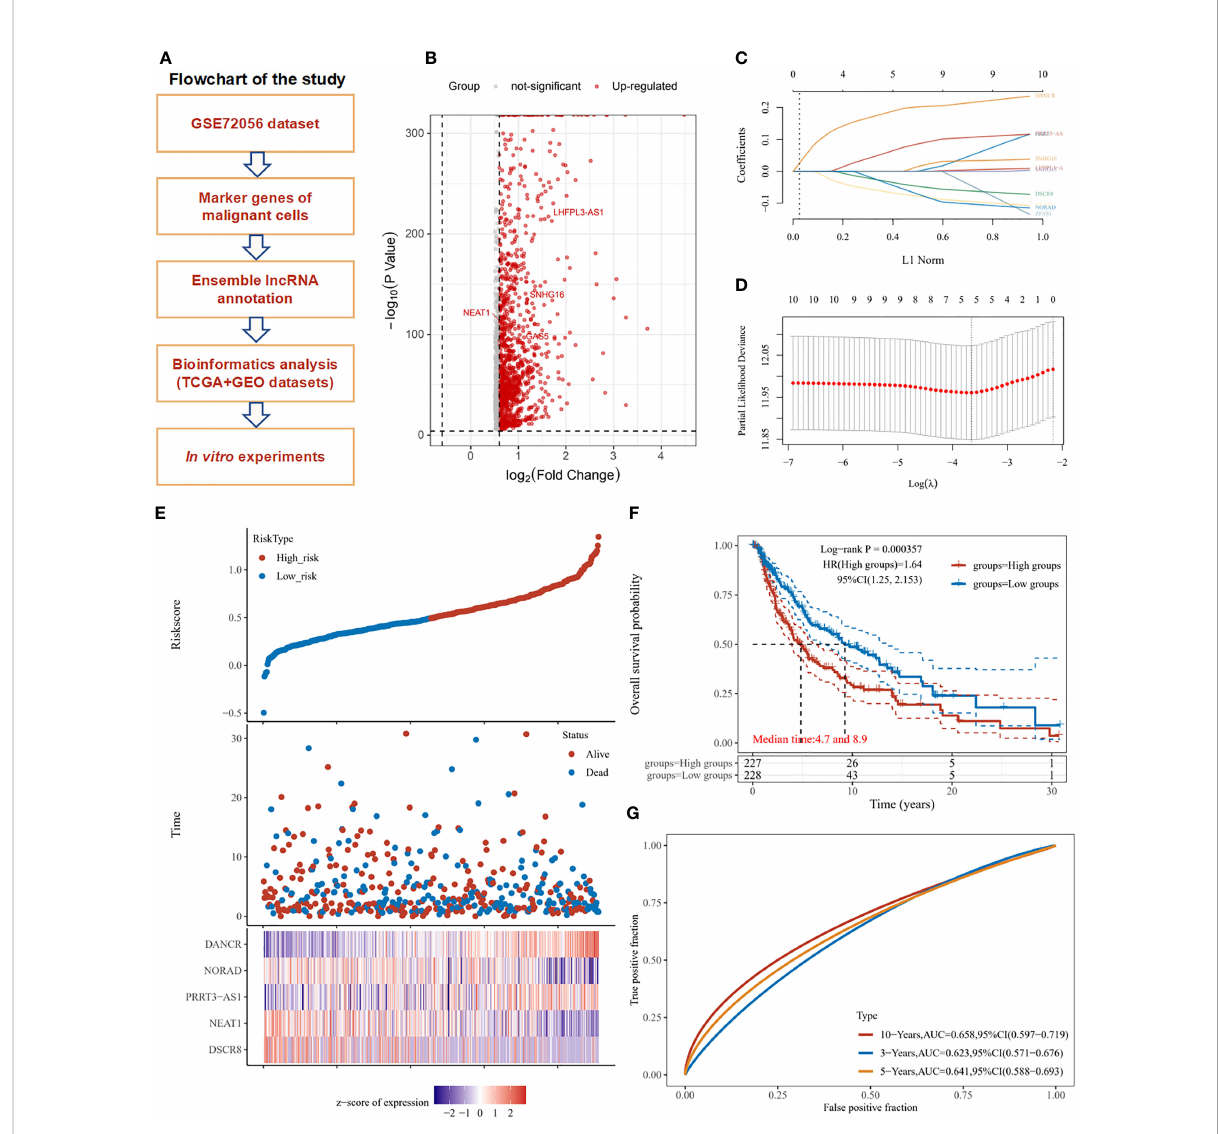
FIGURE 1 Study work fl ow and marker lncRNAs prognosis model construction in SKCM. (A) Work fl ow of the study. (B) Volcano plot exhibits the marker RNAs of melanoma cells in GSE72056. (C) LASSO coef fi cient pro fi les of the marker lncRNAs for overall survival in GSE72056. (D) Partial likelihood deviance of overall survival for the LASSO coef fi cient pro fi les. Five features with non-zero coef fi cients were selected by optimal lambda. (E) Melanoma patients were sorted by risk score, based on which patient status and the selected lncRNA expression of each patient was exhibited. Distribution of risk score (upper fi gure), OS (middle fi gure), and heat map of DANCR, NORAD, PRRT3-AS1, NEAT1, and DSCR8 expression in the GSE72056 dataset (lower fi gure). (F) Survival curves and patient status of 5-marker-lncRNAs. (G) ROC curves compare the prognostic accuracy of the classi fi er in melanoma patients using AUCs at 1, 5, and 10 years to assess prognostic